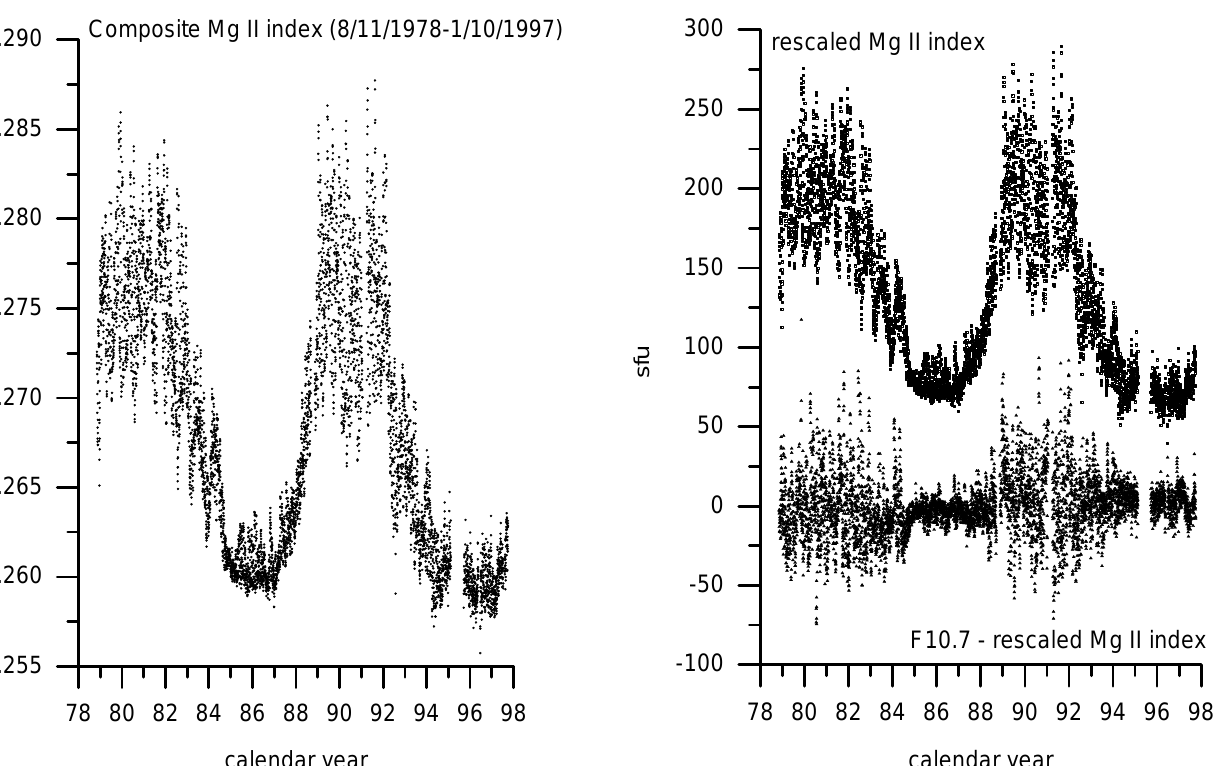
Fig. 3. The composite Mg II index scaled to the NOAA-9 observa- tions. Data gaps of less than three days have been filled by interpo- lation.